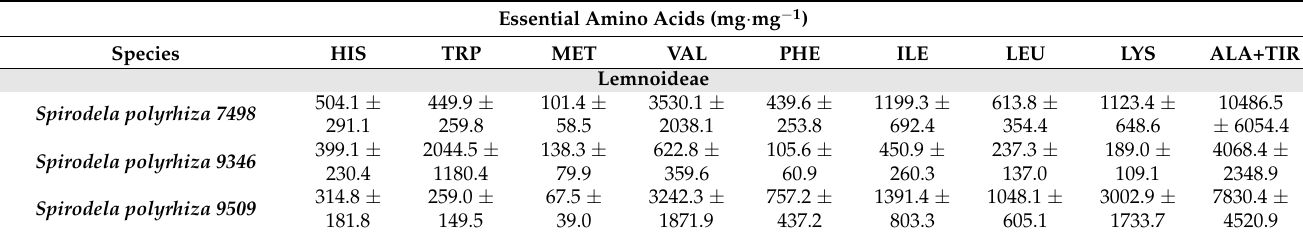
Table 4. Essential amino acids composition of 21 duckweeds ecotypes. Data represented in g · mg − 1 dry weight by average ± standard error ( n = 3). HIS: histidine, TRP: tryptophan, MET: methionine, VAL: valine, PHE: phenylalanine, ILE: isoleucine, LEU: leucine, LYS: lysine, ALA: alanine, and TYR: tyrosine. Data represented by the mean ± standard error ( n =